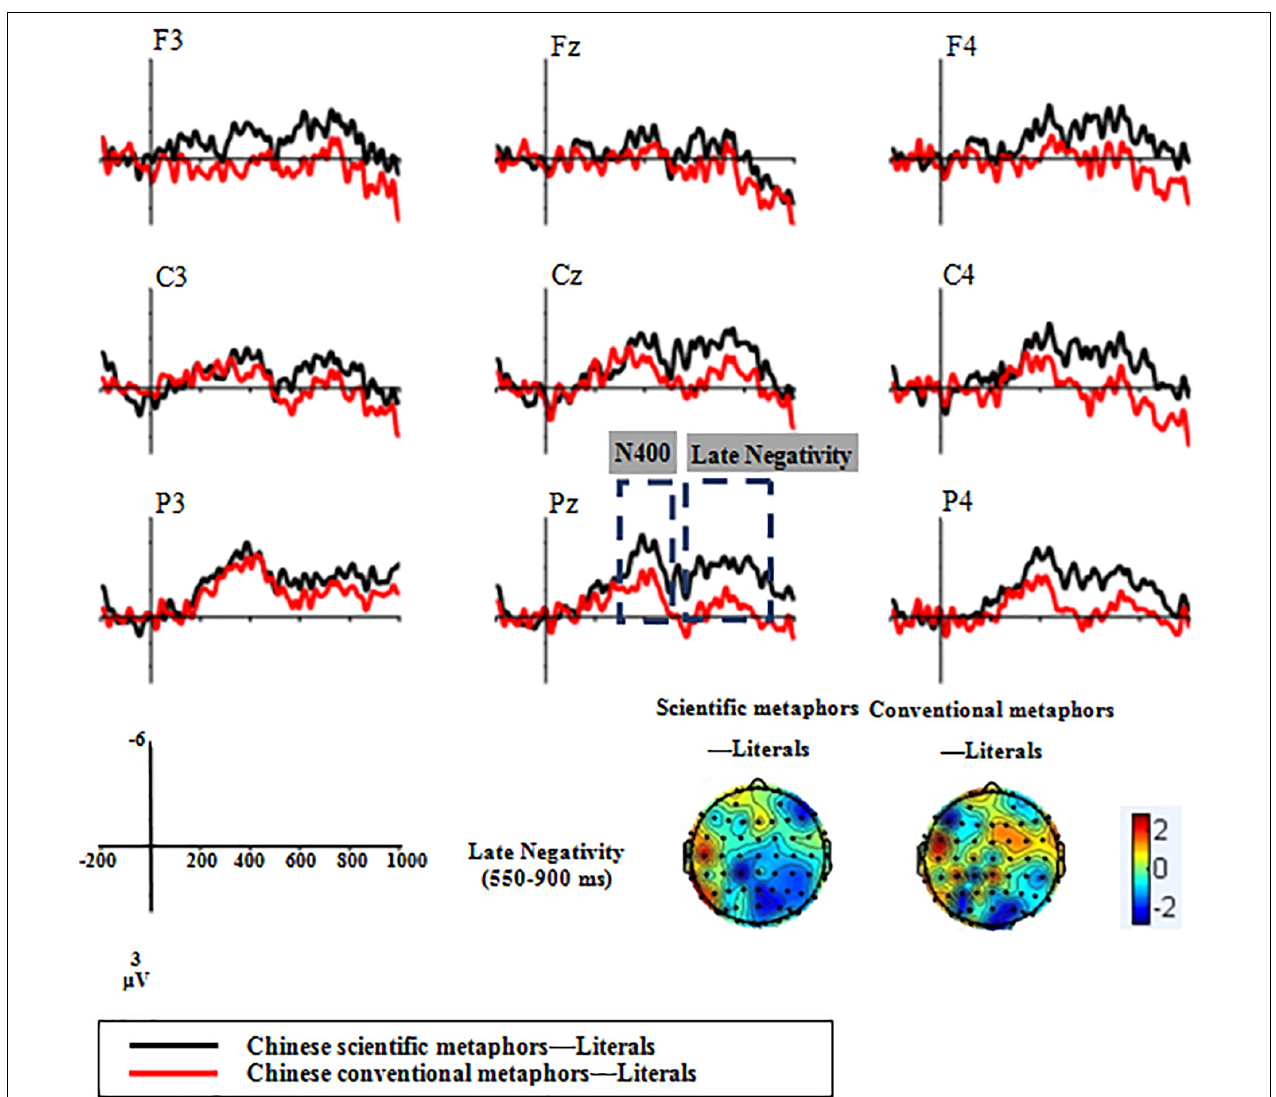
FIGURE 3 | Topographic plots of the two kinds of Chinese metaphors subtracting the literal from the metaphoric in the 300–500 and 550–800 ms time